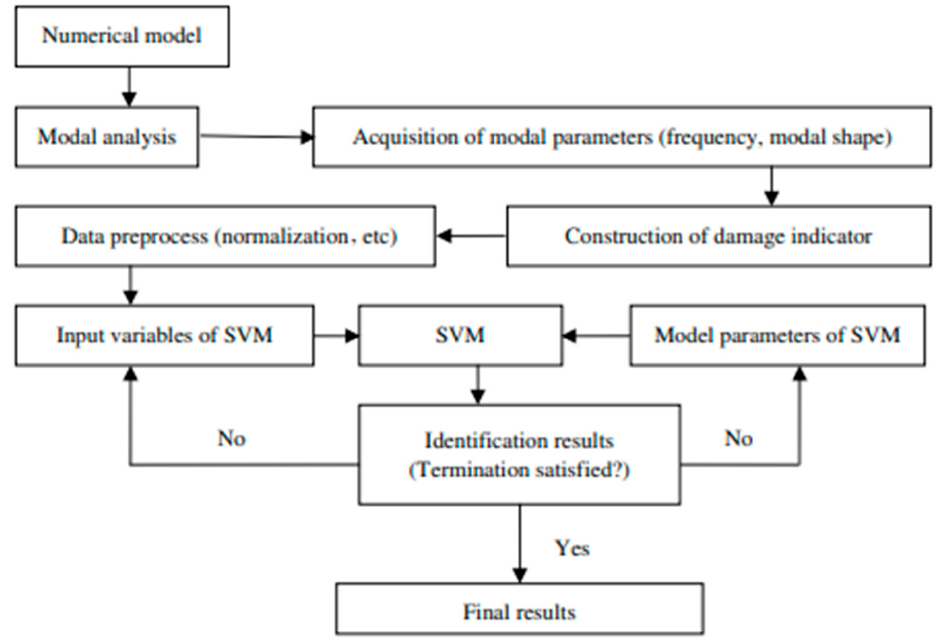
Figure 4. An example of an SVM-based structural damage identification system [114]